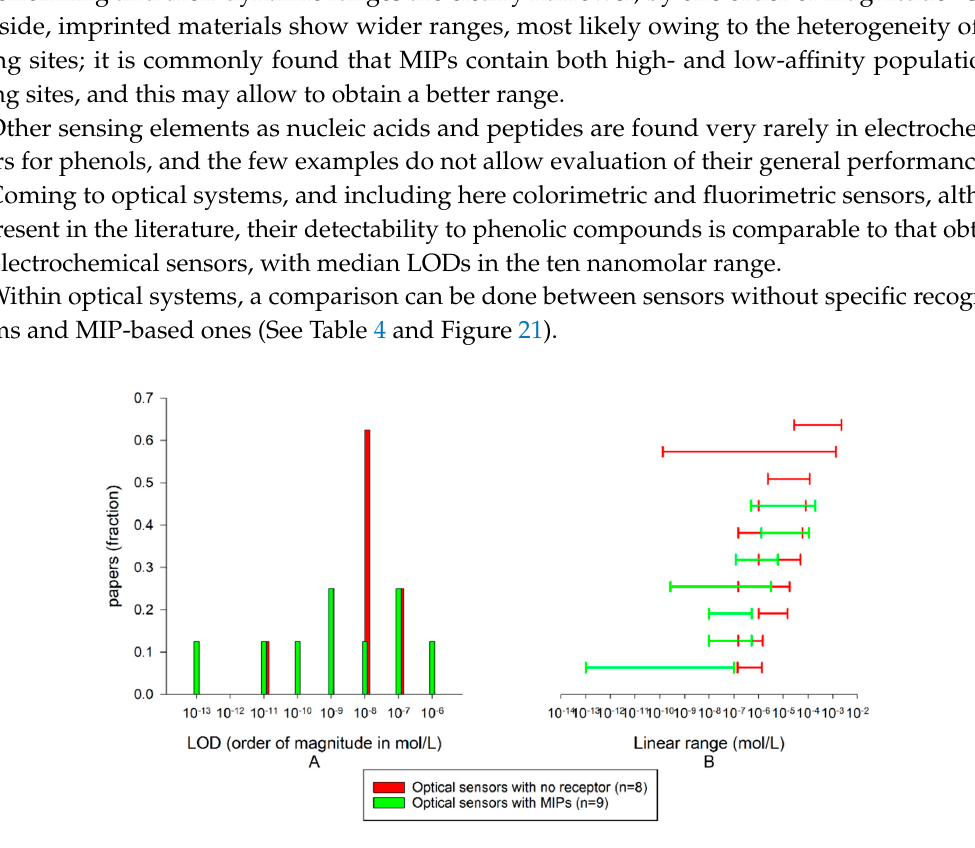
Figure 21. ( A ): distribution of LODs of optical sensors in the papers examined in this review; ( B ): linear response ranges of optical sensors in the papers examined in this review. This time the comparison is quite favorable to MIPs, as both to the number of examples with low detectabilities and to the dynamic range width. A minority of optical systems show activation of